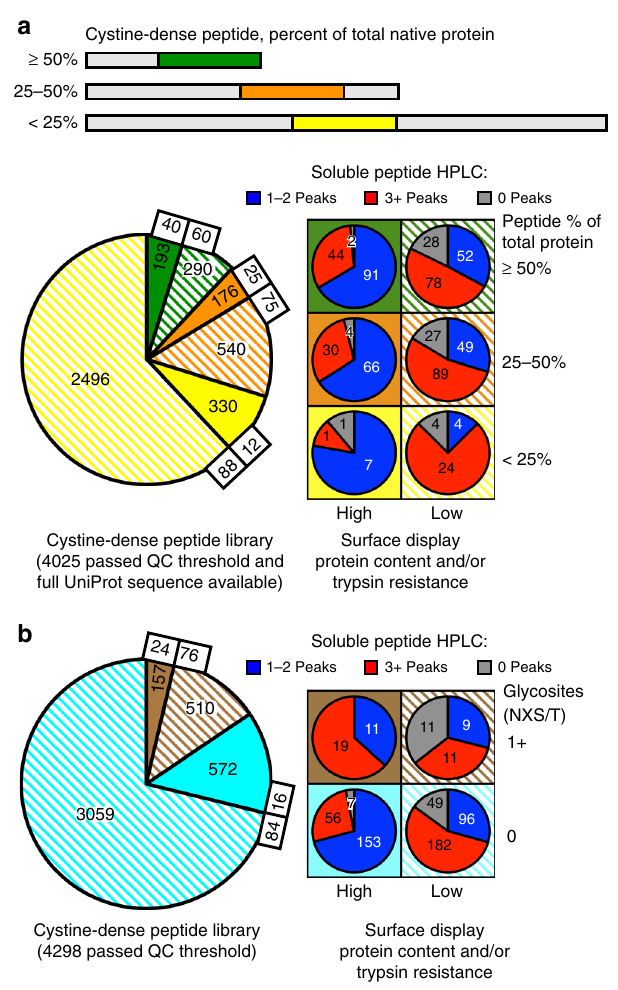
Fig. 3 Effects of a CDP ’ s native protein context, and glycosylation, on surface and solution properties. a Categorizing the tested CDPs by the proportion of the native, full-length protein they represent, either < 25% (yellow), 25-50% (orange), or ≥ 50% (green). The measured surface display protein content/trypsin resistance properties (solid, high; dashed, low) and HPLC classi fi cation (1-2 Peaks, blue; 3+ Peaks, red; 0 Peaks, gray) are shown per category. Proportions of high content / trypsin resistant peptides are signi fi cantly different ( P < 0.0001) between all categories. b Same analysis as in a , but categorized by the presence (brown) or absence (cyan) of canonical N-linked glycosites (NXS or NXT) within the peptide. The presence of a glycosite correlates with a signi fi cantly ( P < 0.0001) higher probability of having high surface display protein content / trypsin resistance, but such high protein content / trypsin resistant, glycosite-containing peptides (solid brown) have signi fi cantly fewer ( P < 0.0001) 1 – 2 Peak peptides than expected when compared to high protein content/trypsin resistant CDPs that lack NXS or NXT sites (solid cyan). Signi fi cance calculated by two-tailed Chi Square